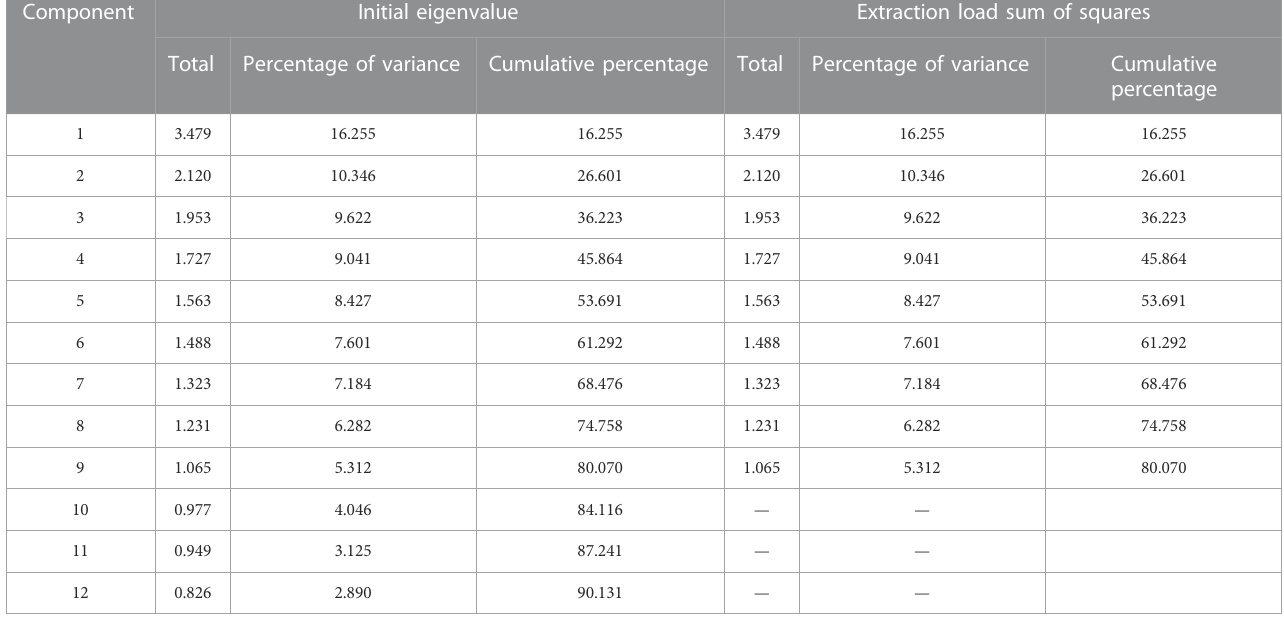
TABLE 3 Total variance of interpretation.